Question: Does the figure show an increasing or a decreasing trend?
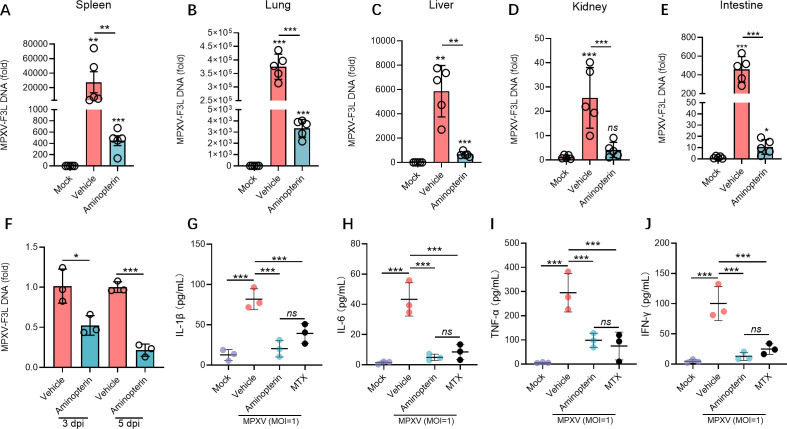
Answer: decreasing